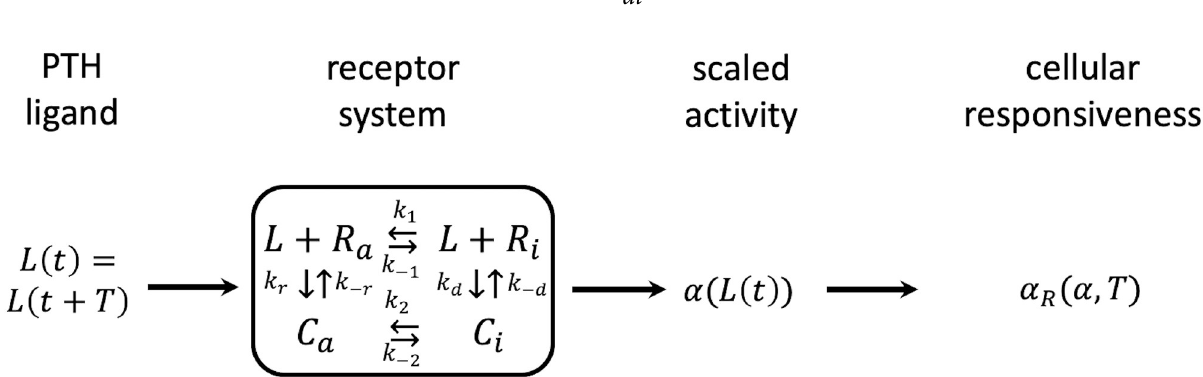
Fig 1. Schematic of the two-state receptor model representing PTH to PTH1R binding based on [16]. L ( t ) = PTH concentration; t = time; T = = active receptor concentration; R = inactive receptor concentration; C = active ligand-receptor complex concentration, C period; R a i a ligand-receptor complex concentration, k ± i = kinematic parameters ( i 2 {1, 2, d , r }); α = scaled activity; α R = cellular responsivenes .